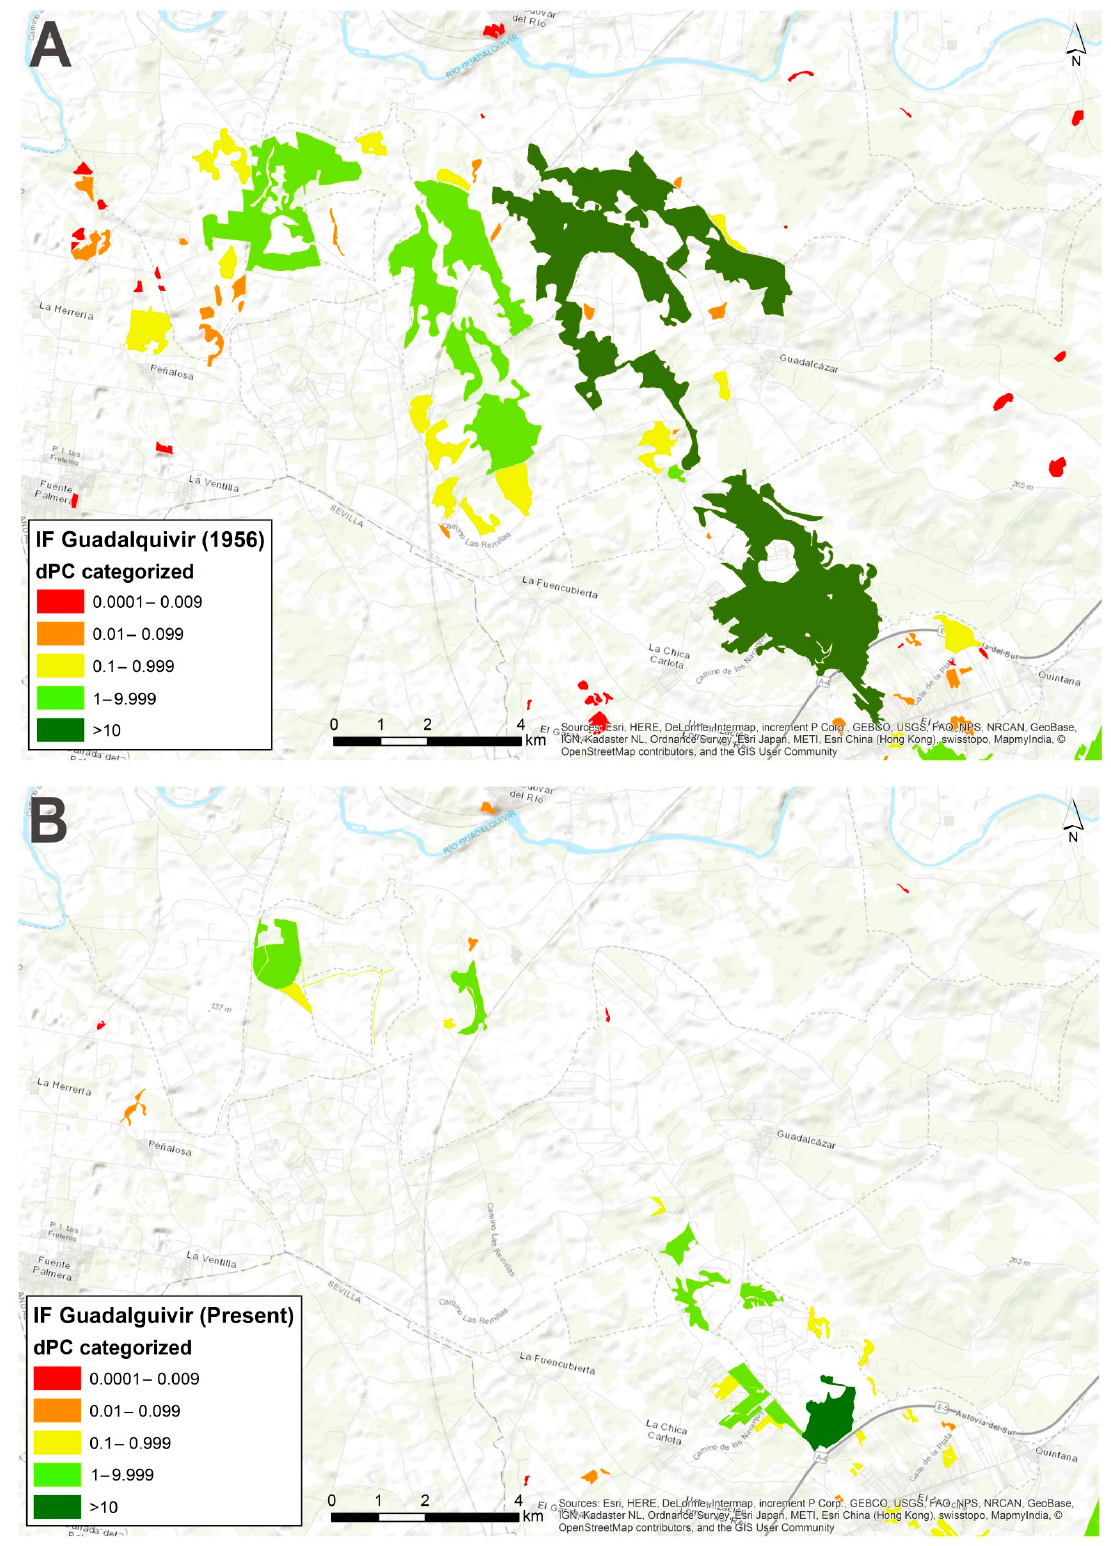
Figure 7. A comparative analysis of fragmentation status in an area located to the southwest of the city of Córdoba (Spain). ( A ): IFs in 1956 with high values of dPC. ( B ): Present situation of IFs. Only a few patches remain, and fragmentation has increased.